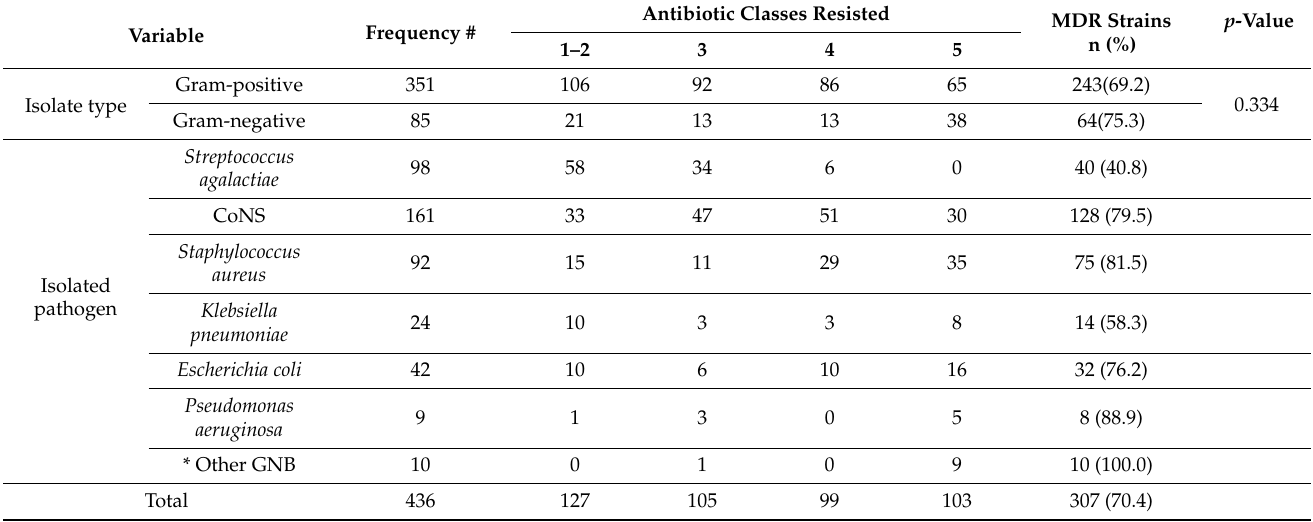
Table 6. Proportion of MDR strains of bacteria pathogens causing neonatal